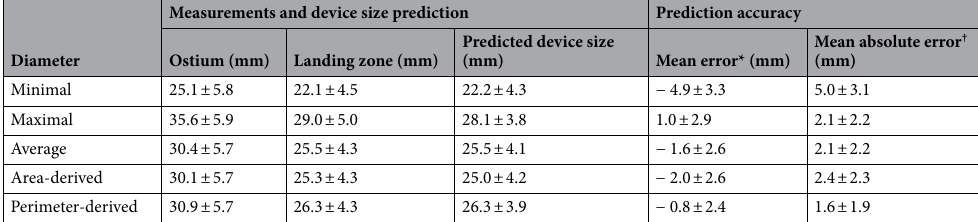
Table 2. Diameters and predicted device sizes. Data are reported as means ± SDs. *The mean of the differences between predicted device size and actual device size. † The mean of the absolute differences between predicted device size and actual device